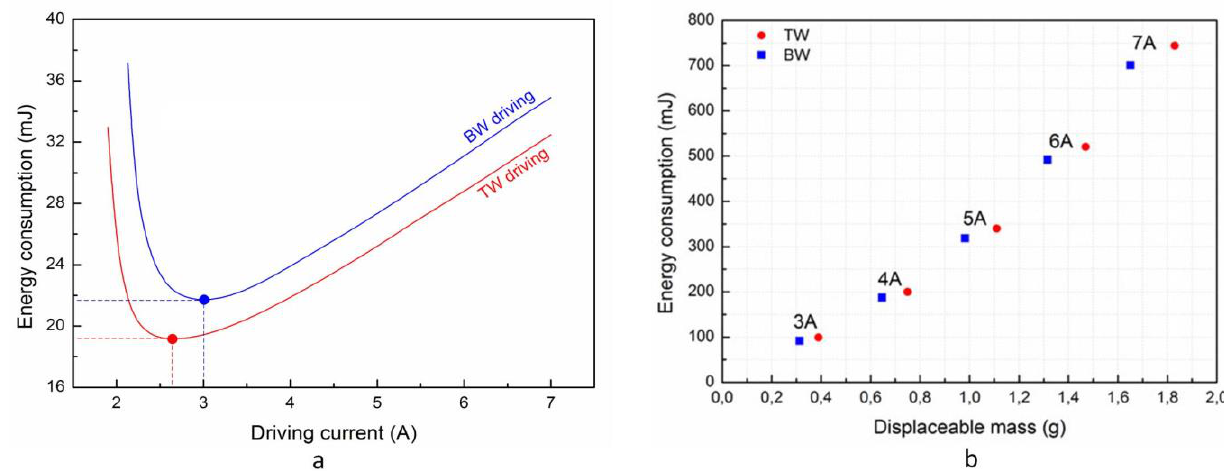
Figure 3. Simulation results: ( a ) energy consumption as function of the driving current value and ( b ) energy consumption as function of the displaceable mass for different driving current